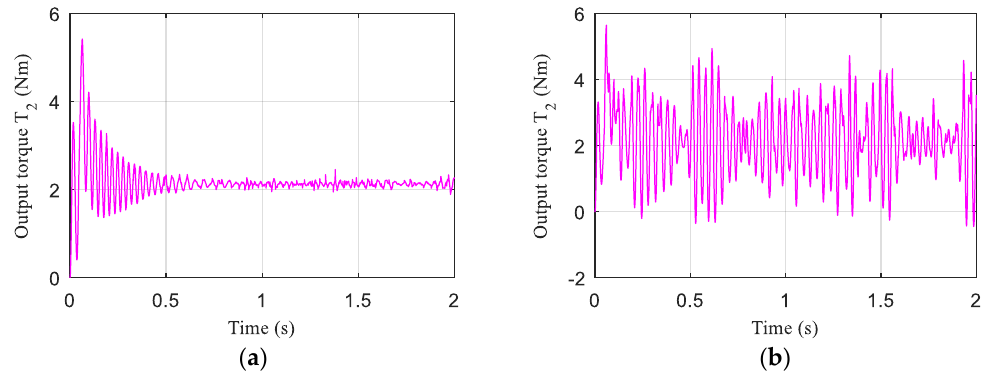
Figure 21. The output torque curve of the joint during stiffness tracking. ( a ) The expected joint stiffness is a sine wave signal. ( b ) The expected joint stiffness is a random signal.